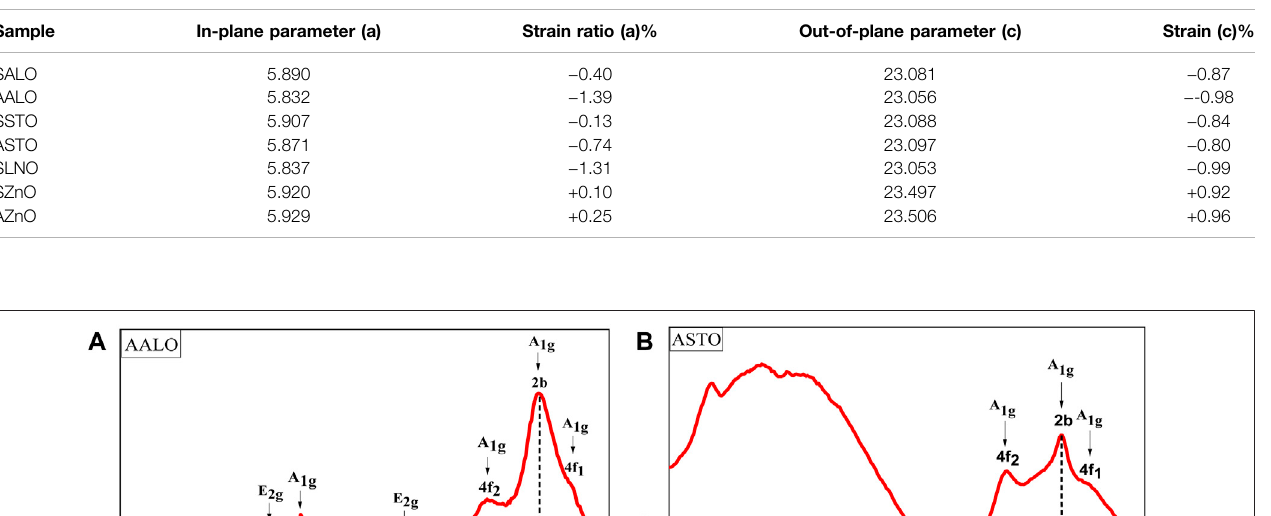
TABLE 1 | Lattice parameters and strain ratio of the SrM fi lms grown on different substrates.